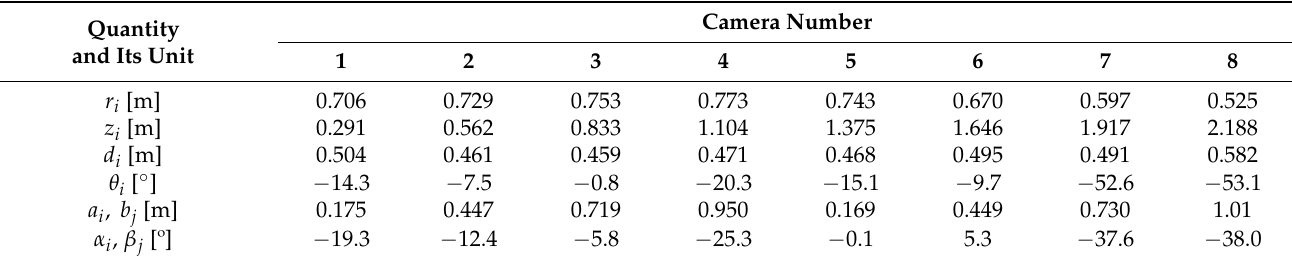
Table 2. Geometrical parameters characterizing the arrangement of the HUBO scanner cameras for an exemplary numerical analysis.